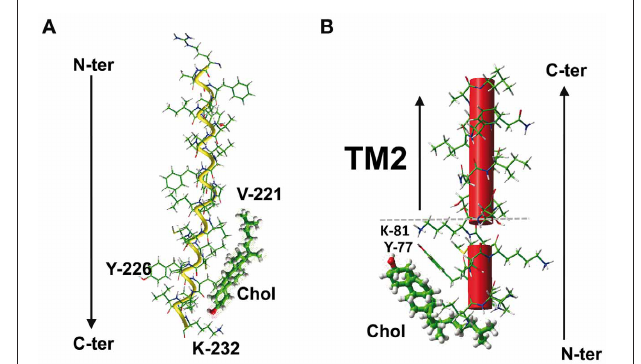
FIGURE 4 | The CRAC/cholesterol complex in a membrane environment. (A) Docking of cholesterol on the CRAC domain of the TM5 domain of human type 3 somatostatin receptor. The CRAC domain (221- V ICLC Y LLIVV K K-232) is located in the cytoplasmic leaflet of the membrane bilayer. Note that the central Y-226 residue of CRAC is not involved in cholesterol interaction. The total energy of interaction has been estimated at − 43kJ.mol − 1 (Baier et al., 2011). (B) Docking of cholesterol on the CRAC domain close the TM2 domain of human delta-type opioid receptor. In this case, the CRAC domain (fragment 74- IV R Y T K M K -81) lies outside the membrane. The aromatic side chain of Y-77 plays a critical role in this interaction (see Figure 5 ). The polar-apolar interface of the membrane is indicated by a dotted gray